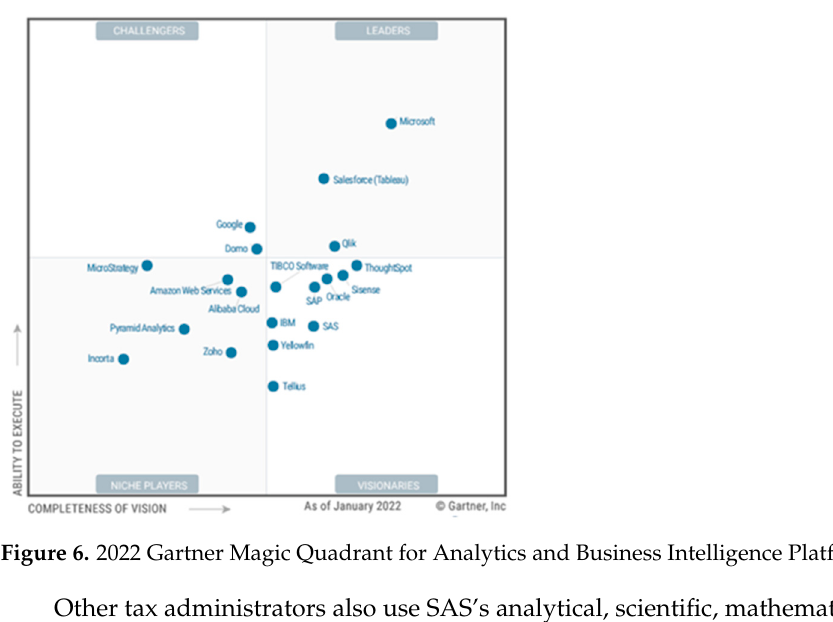
Figure 5. 2021 Gartner Magic Quadrant for Analytics and Business Intelligence Platforms.